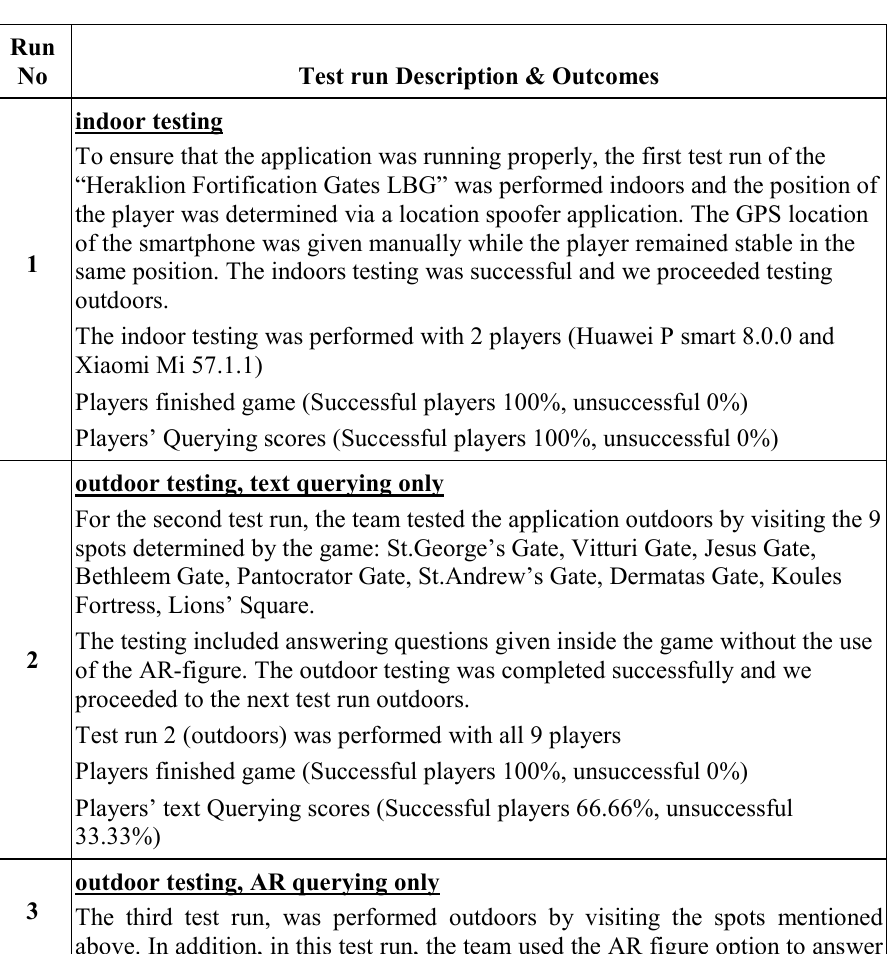
Table 2. Test runs & preliminary